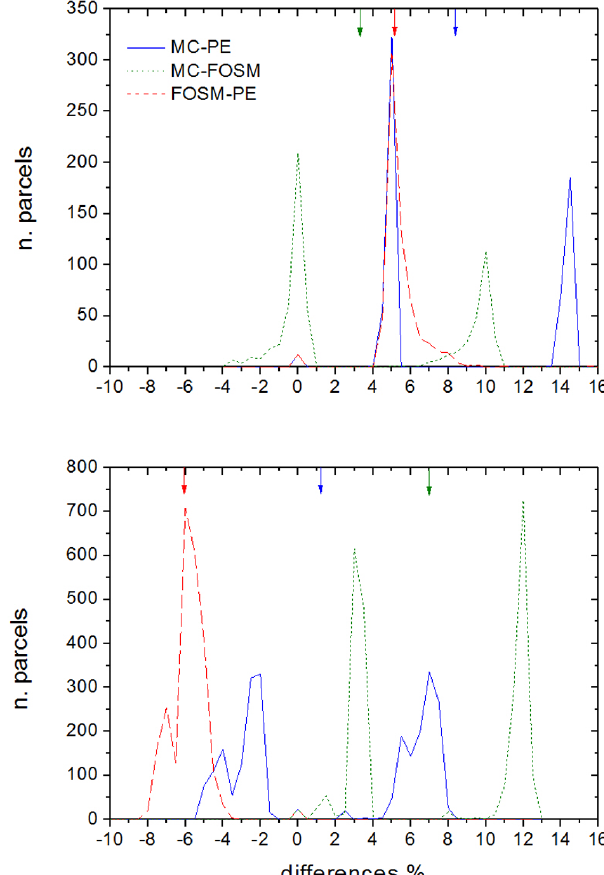
Fig. 14. Frequency of the differences in expected loss values between couples of methods for (a) flood 500-yr scenario, and (b) seismic 475-yr scenario. Arrows indicate the mean value of the differences for the whole study